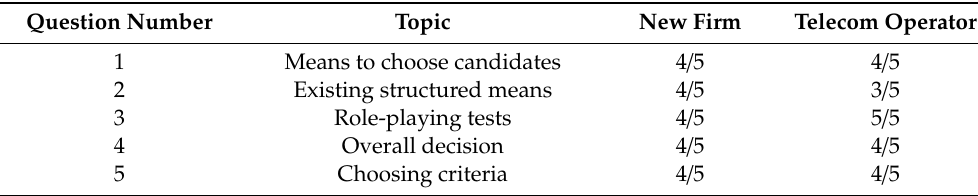
Table 3. Choosing candidates and employer branding.